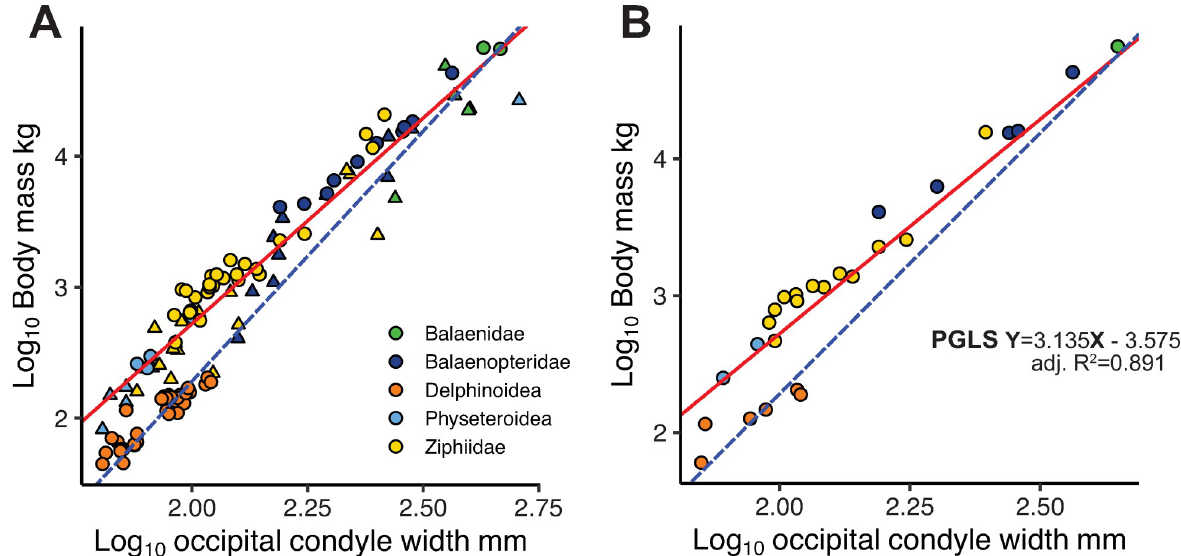
Fig 5. Scaling of occipital condyle width (OCW) and body mass in extant cetaceans. Red line shows our PGLS regression (Eq 3) for adults (species averages) in both plots. (A) Plot including all data (S2 Table in S2 File); circles represent adult individuals, triangles represent sub-adults; blue line represents the regression of Marino et al. [7] reported in Boessenecker et al. [9]. (B) Plot of adult species means which form the basis of our regression (red